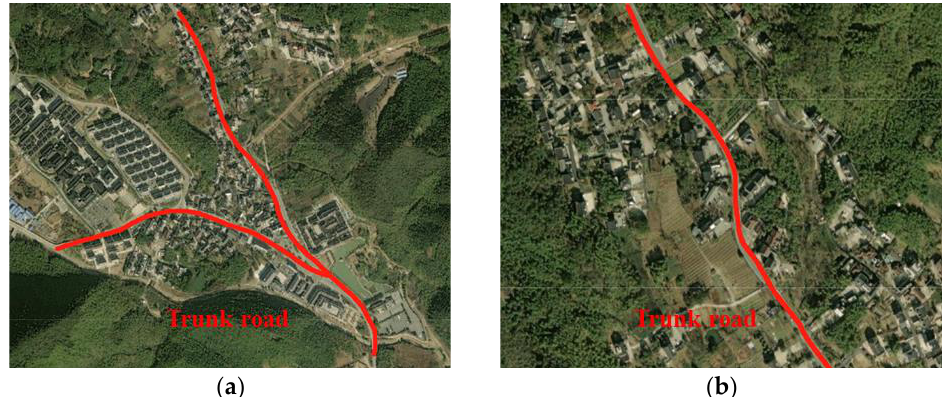
Figure 10. Topographic map of the home hotel village: ( a ) overall topographic map of the home hotel village; ( b ) local topographic map of the home hotel